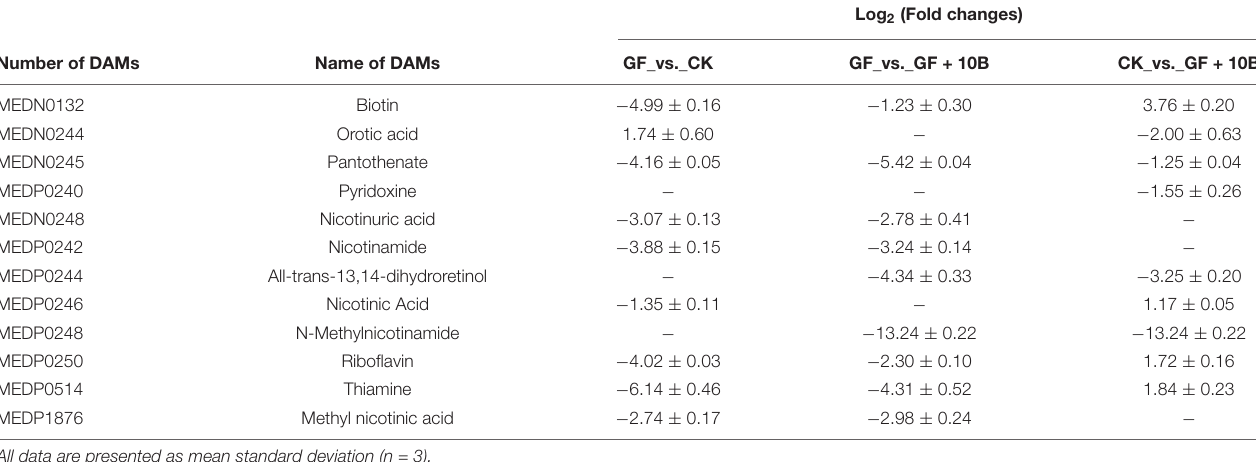
Log 2 (Fold changes)